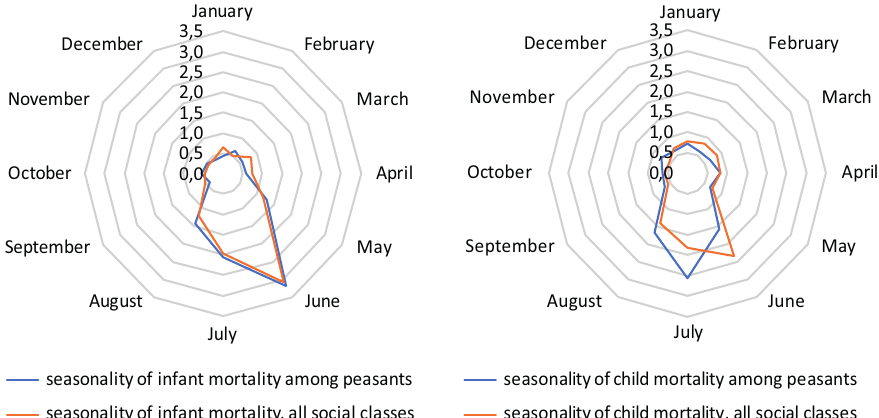
Figure 4. Seasonal indices of infant mortality (left) and child mortality (right) among peasants in the Pokrovsky parish (1877-1897), both sexes. Source: author’s calculations based on parish